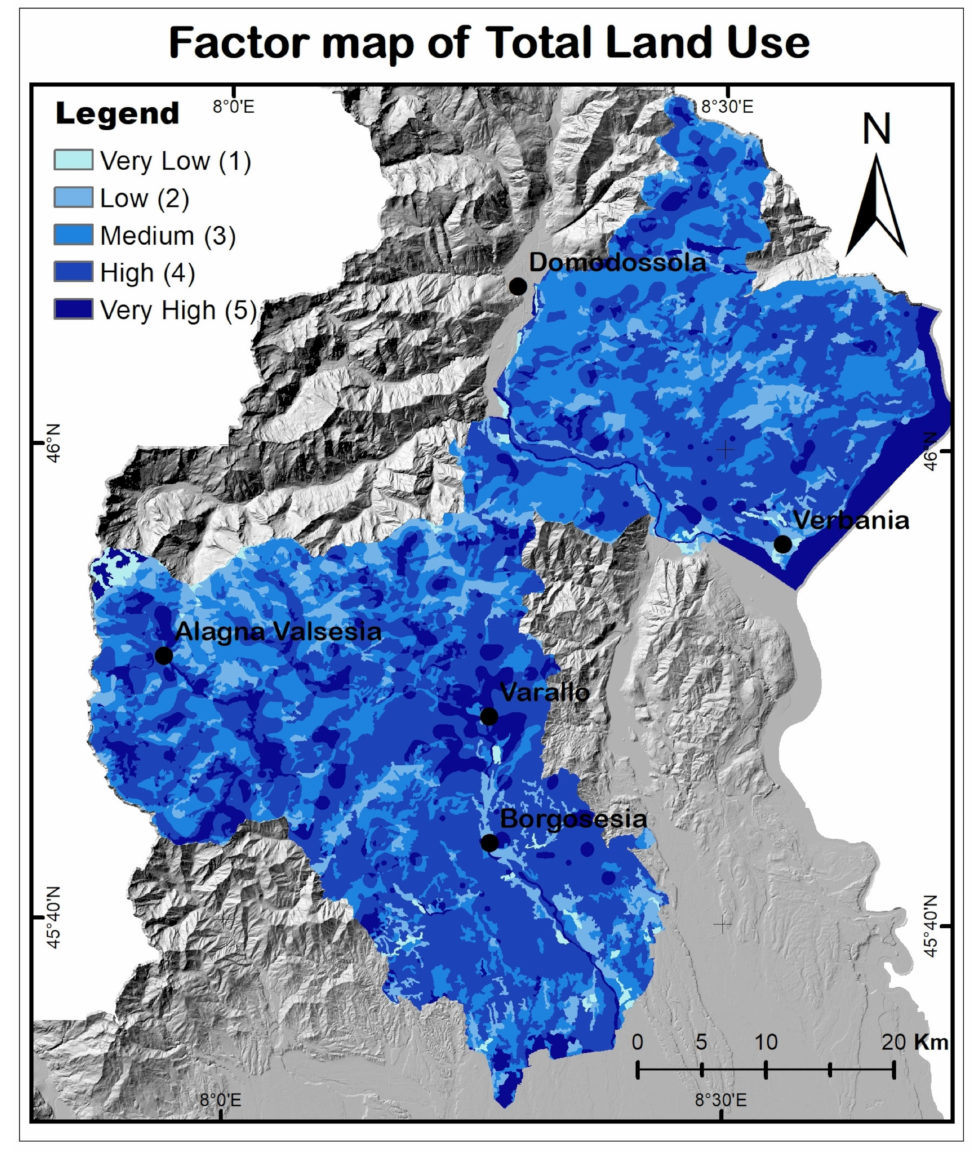
Figure 7. Factor map of land use integrated with landslides density index